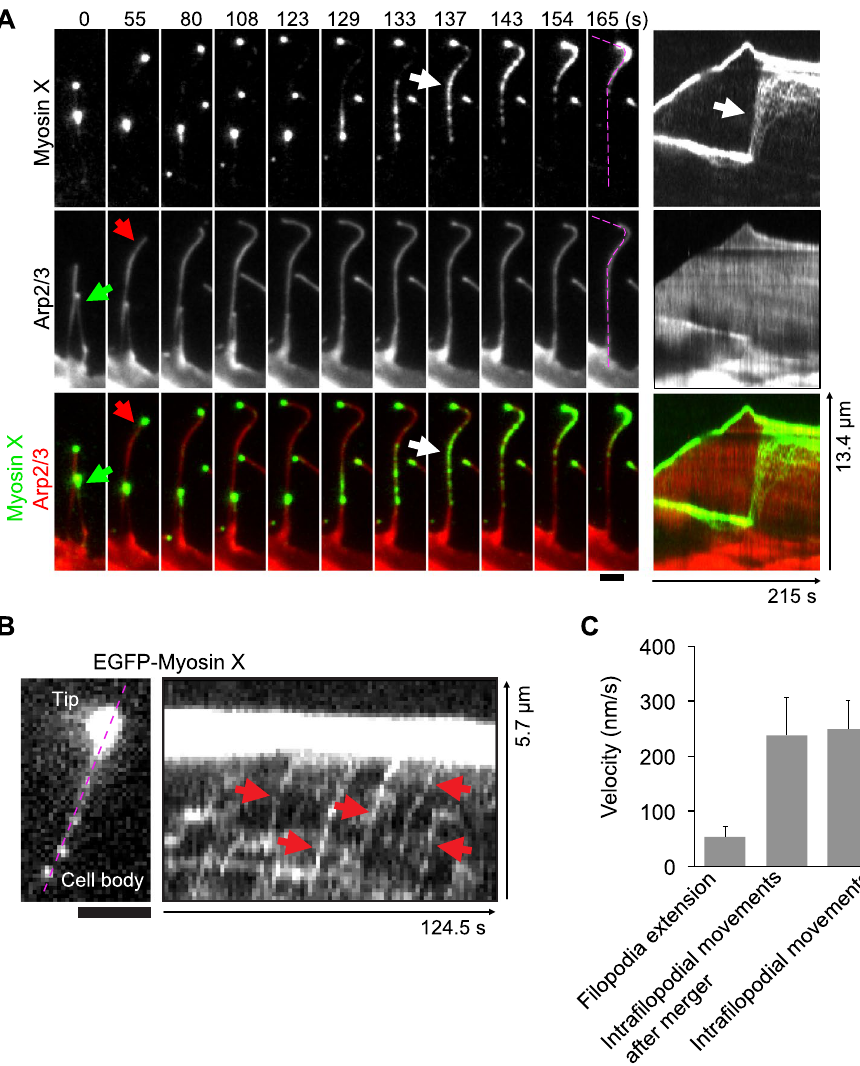
Figure 6. Myosin X behavior during merger of filopodia. ( A ) Time-lapse montages of EGFP-myosin X and mCherry-Arp2/3 show the quick movement of myosin X (white arrow) originally located at the tip of the short filopodia (green arrows) toward the tip of the longer filopodia (red arrows). Kymographs of EGFP-myosin X and mCherry-Arp2/3 along filopodial extension (purple dashed lines) were obtained, with the white arrow pointing to the quick movement of myosin X to the tip of the longer filopodia. ( B ) The kymograph of EGFP-myosin X movement within filopodia (purple dashed line) shows the fast intrafilopodial movements of myosin X (red arrows) from the cell body to the tip of a pre-existing filopodia. ( C ) Average velocities ( ± s.d.) of the forward movements of filopodial tips during filopodia extension (Filopodia extension, n = 58), the quick forward intrafilopodia movements of myosin X after filopodial fusion as shown in ( A ) (Intrafilopodial movements after merger, n = 47) and the intrafilopodial movements of myosin X as shown in ( B ) (Intrafilopodial movements, n = 55). Scale bars, 2 μ